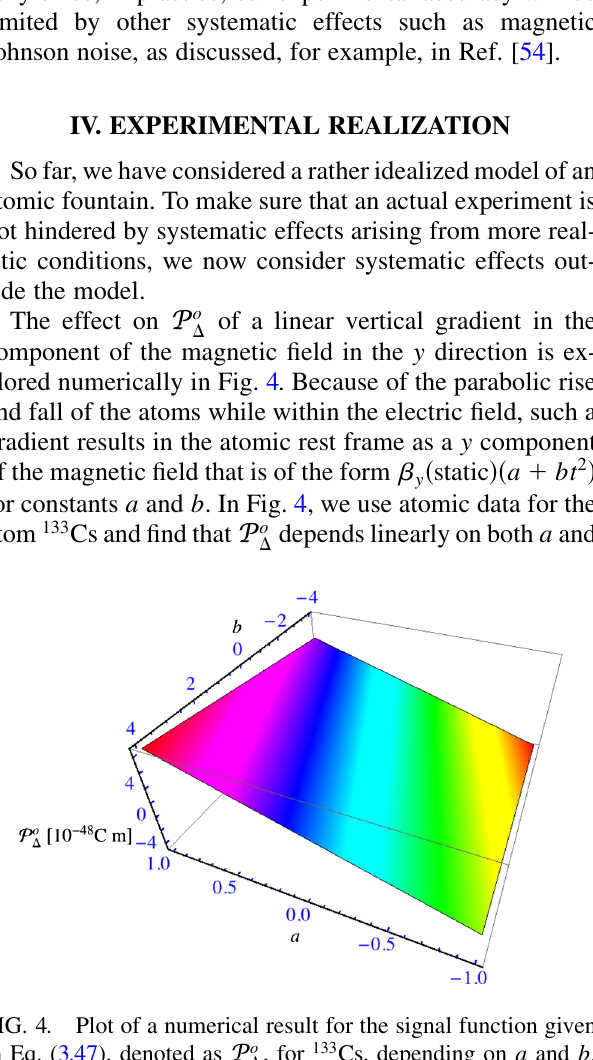
FIG. 5. Plot of a numerical result for the signal function given , for 133 Cs , depending on the deviations (cid:11)k in Eq. (3.47), P o (cid:3) k and (cid:11)k of k from the phase adjustment in Eqs. (2.13) and (cid:9) (cid:10) (cid:10) (2.14),